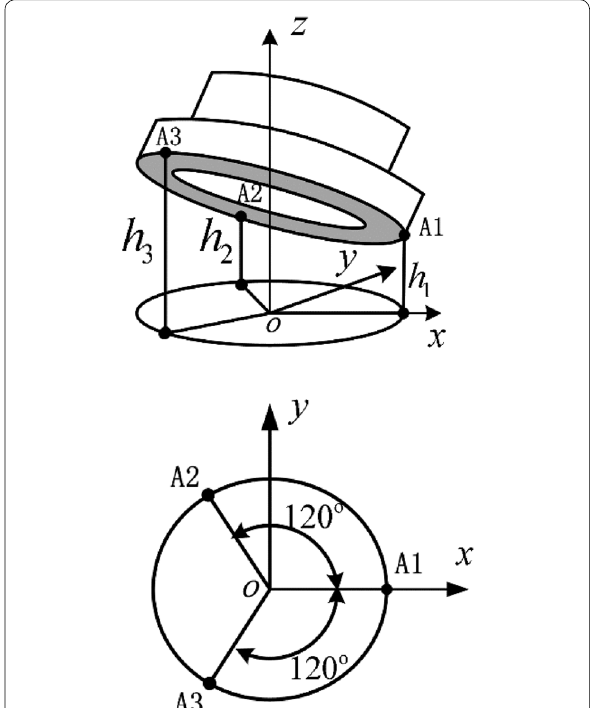
Figure 4 Description method of the 3-point film thickness